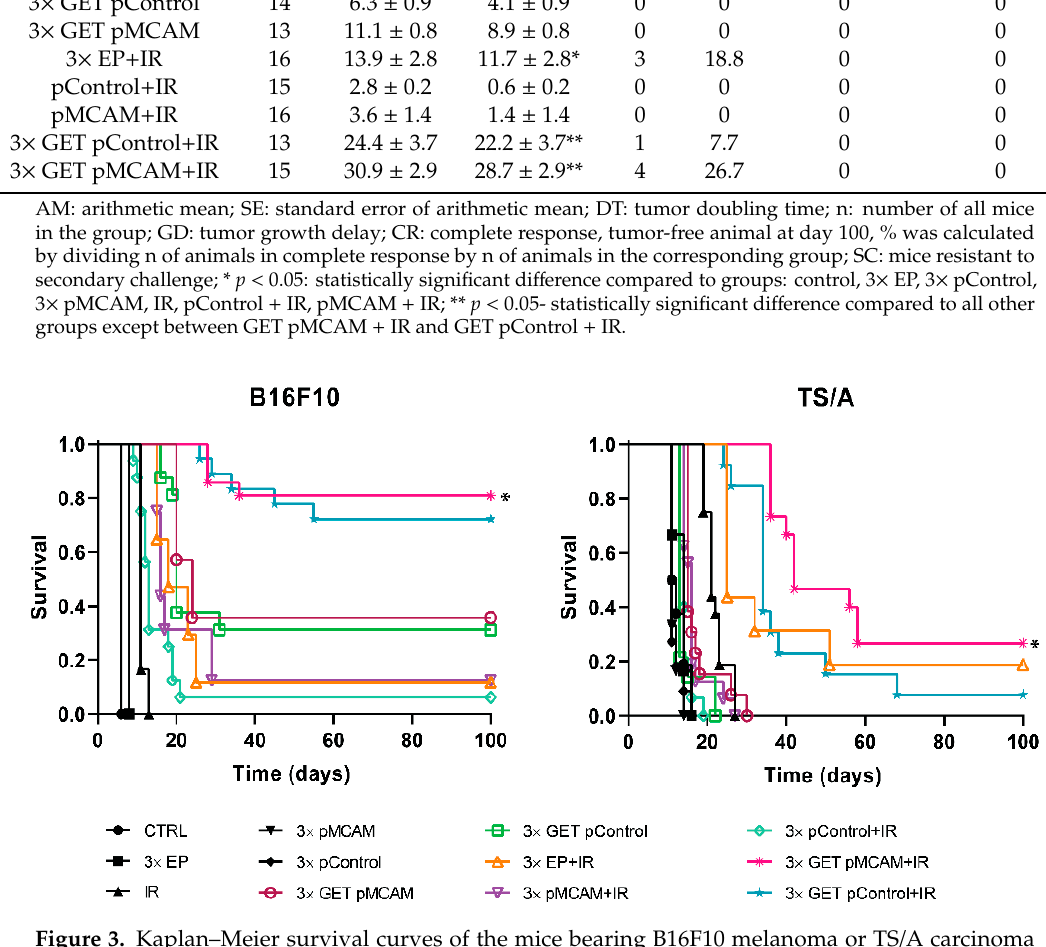
Figure 3. Kaplan–Meier survival curves of the mice bearing B16F10 melanoma or TS/A carcinoma tumors after treatment with gene electrotransfer (GET) of plasmid DNA-encoded shRNA against MCAM (pMCAM) and single-dose irradiation (IR, 15 Gy). The data represent the arithmetic mean and standard error of the mean, n = 9–21; * p < 0.05 significant to all other groups; CTRL: the control group; EP: application of electric pulses; pControl: intratumorally injection of control plasmid.